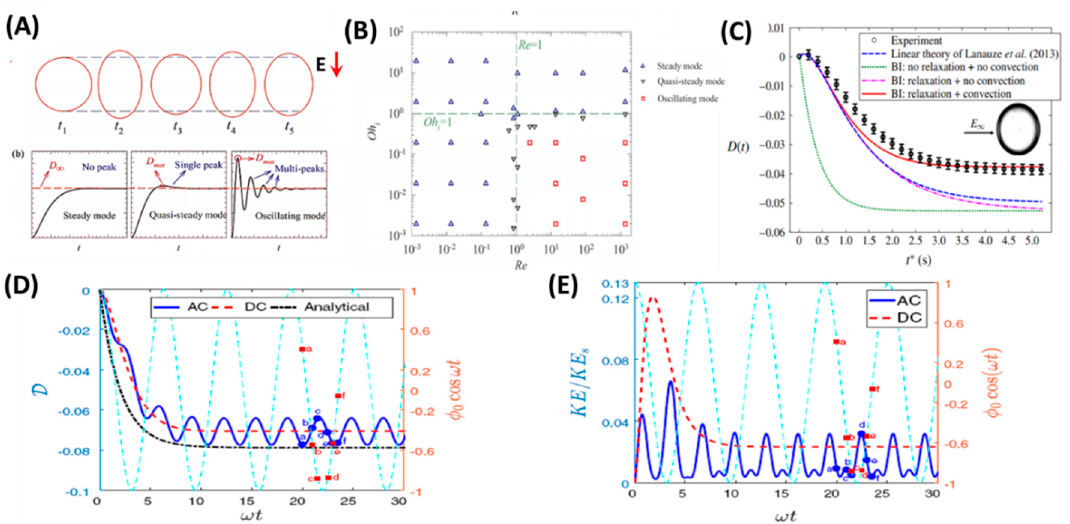
Figure 3. Transient deformation of single-phase emulsion droplet under a weak DC/AC electric field. ( A ) Three different modes of deformation encountered in transient deformation of a droplet. ( B ) The mapping of deformation modes as mentioned in ( A ) on Ohnesorge number ( Oh ) vs. Reynolds Number ( Re ) parametric space [68] . ( C ) The effect of charge relaxation and convection on transient deformation of a silicone oil droplet in castor oil [60] . ( D ) Evolution of the deformation with time. ( E ) Evolution of the kinetic energy of the fluid system with time [101] .